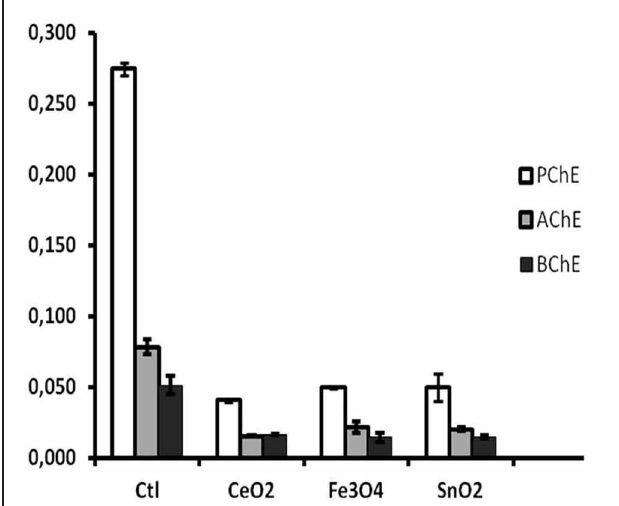
FIGURE 13 | Cholinesterase inhibition by exposure to 10 − 5 mg/L metallic nanopowders (from: Falugi et al., 2012). Ctl, control; CeO2, CeO 2 ; Fe3O4, Fe 3 O 4 ; SnO2, SnO 2 . Y axis, enzyme activity